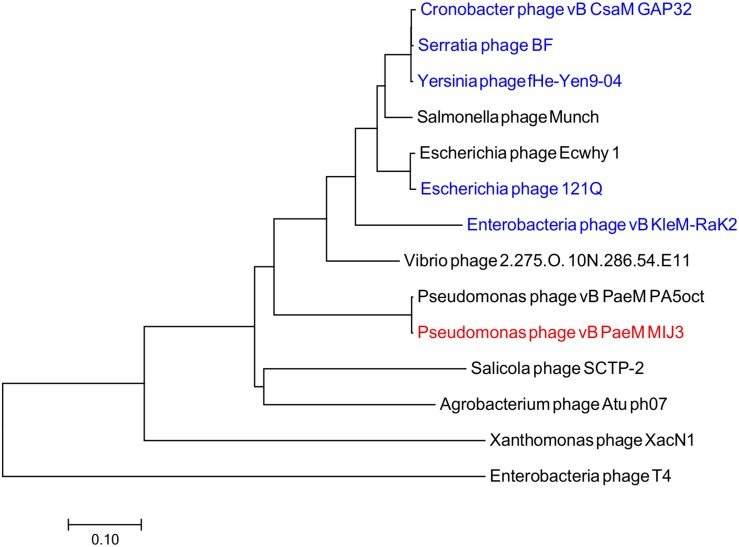
Phylogenetic tree comparing the major capsid protein of phage MIJ3 (red) with its corresponding in other jumbo phages, including Rak2-like phages (blue). Phages were selected as they share homology with the amino acid sequences of the major capsid using Blastp. Phage T4 was selected as an outgroup phage that is not closely related to the corresponding sequence of MIJ3. The evolutionary history was inferred using the neighbor-joining method and the tree was constructed using MEGA7.